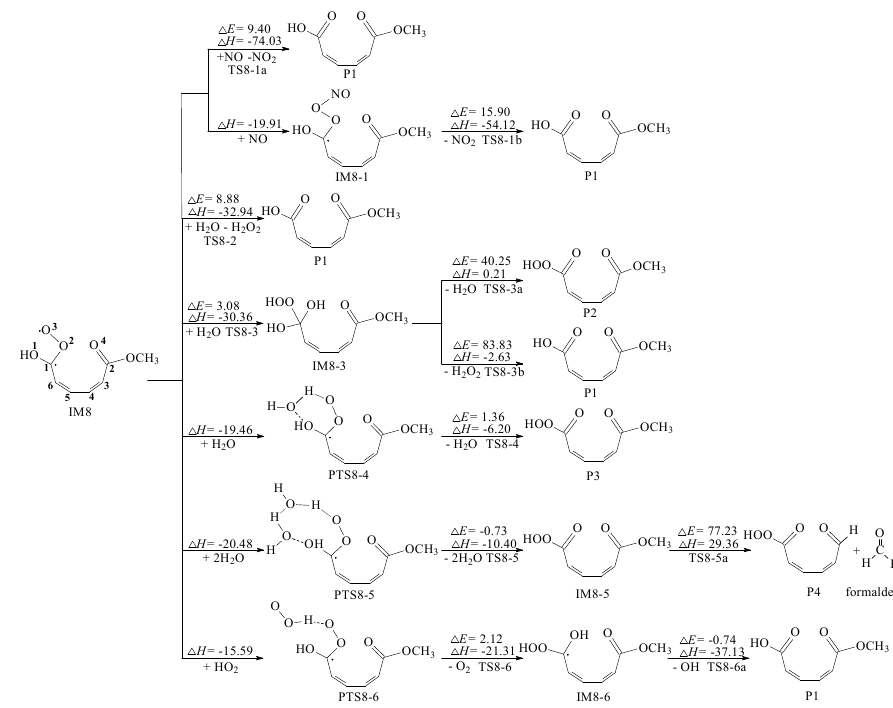
Figure 5. Secondary reactions of IM8 with some small molecules, ∆ E : potential-energy barriers, ∆ H : heats of reaction, TS: transition state, IM: intermediate, P: